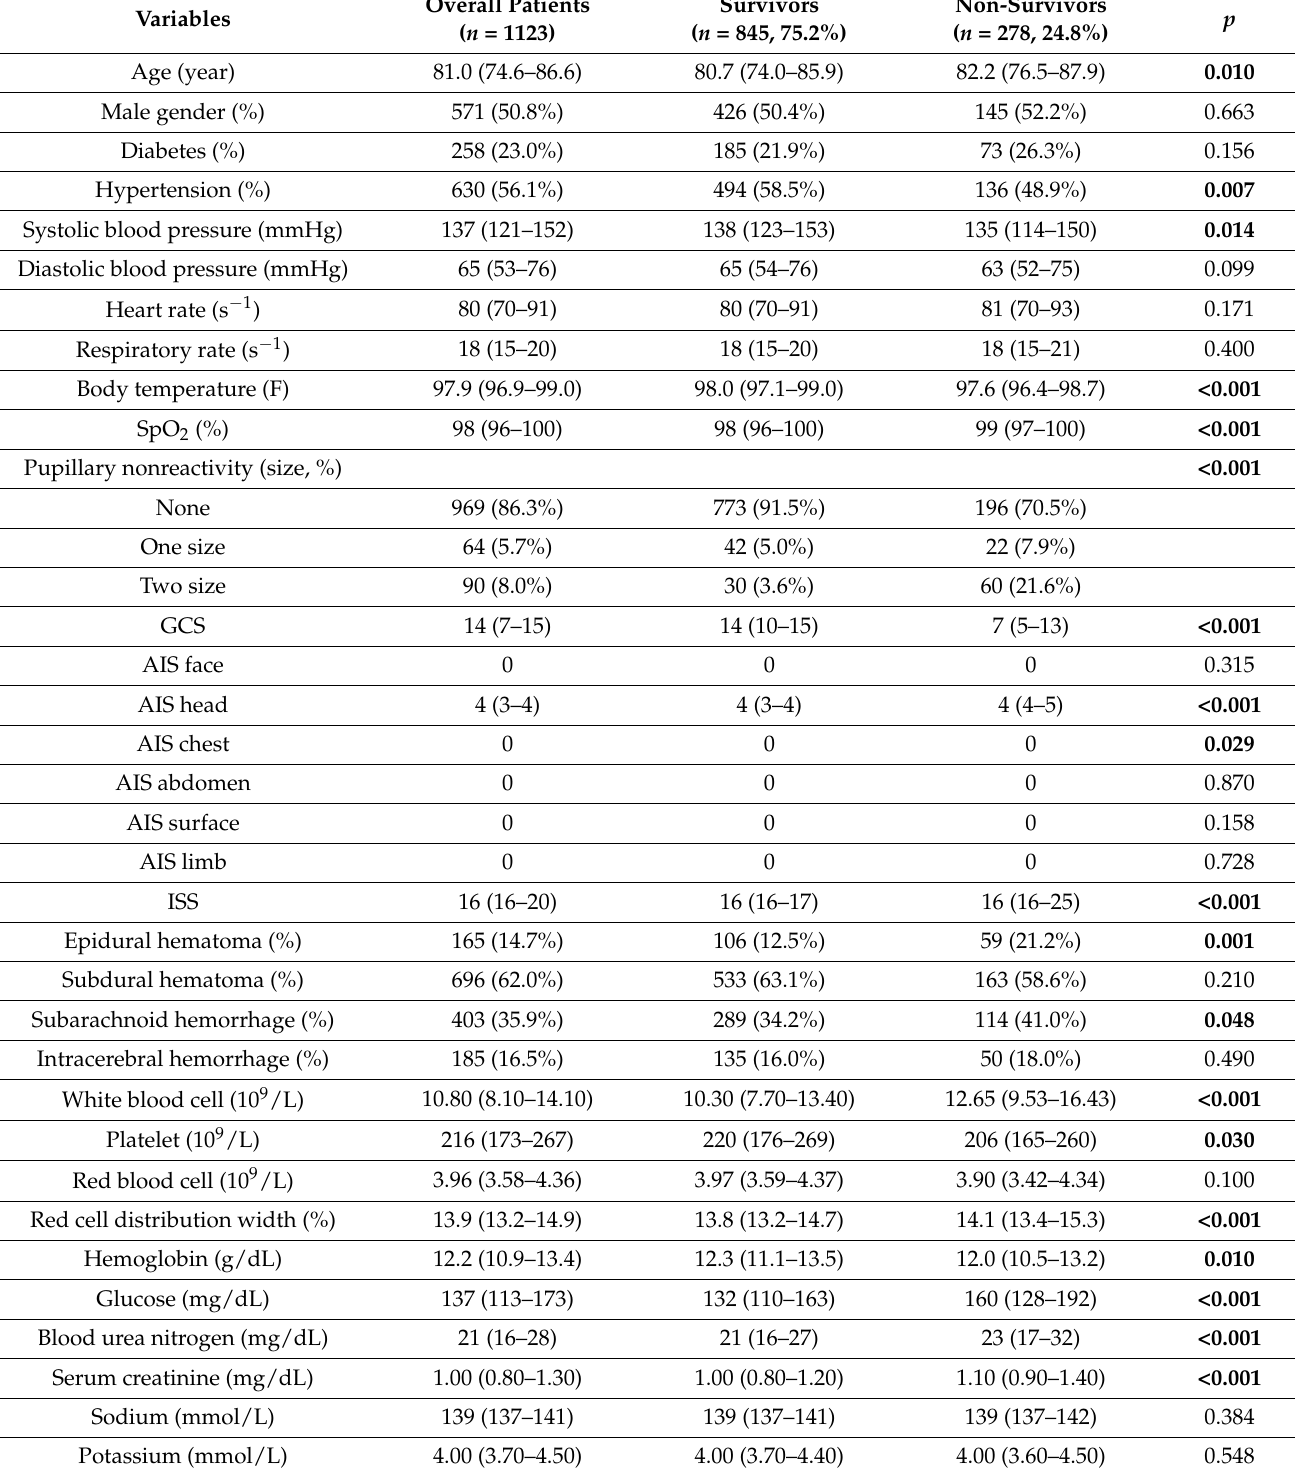
Table 1. Baseline characteristics of geriatric TBI patients in